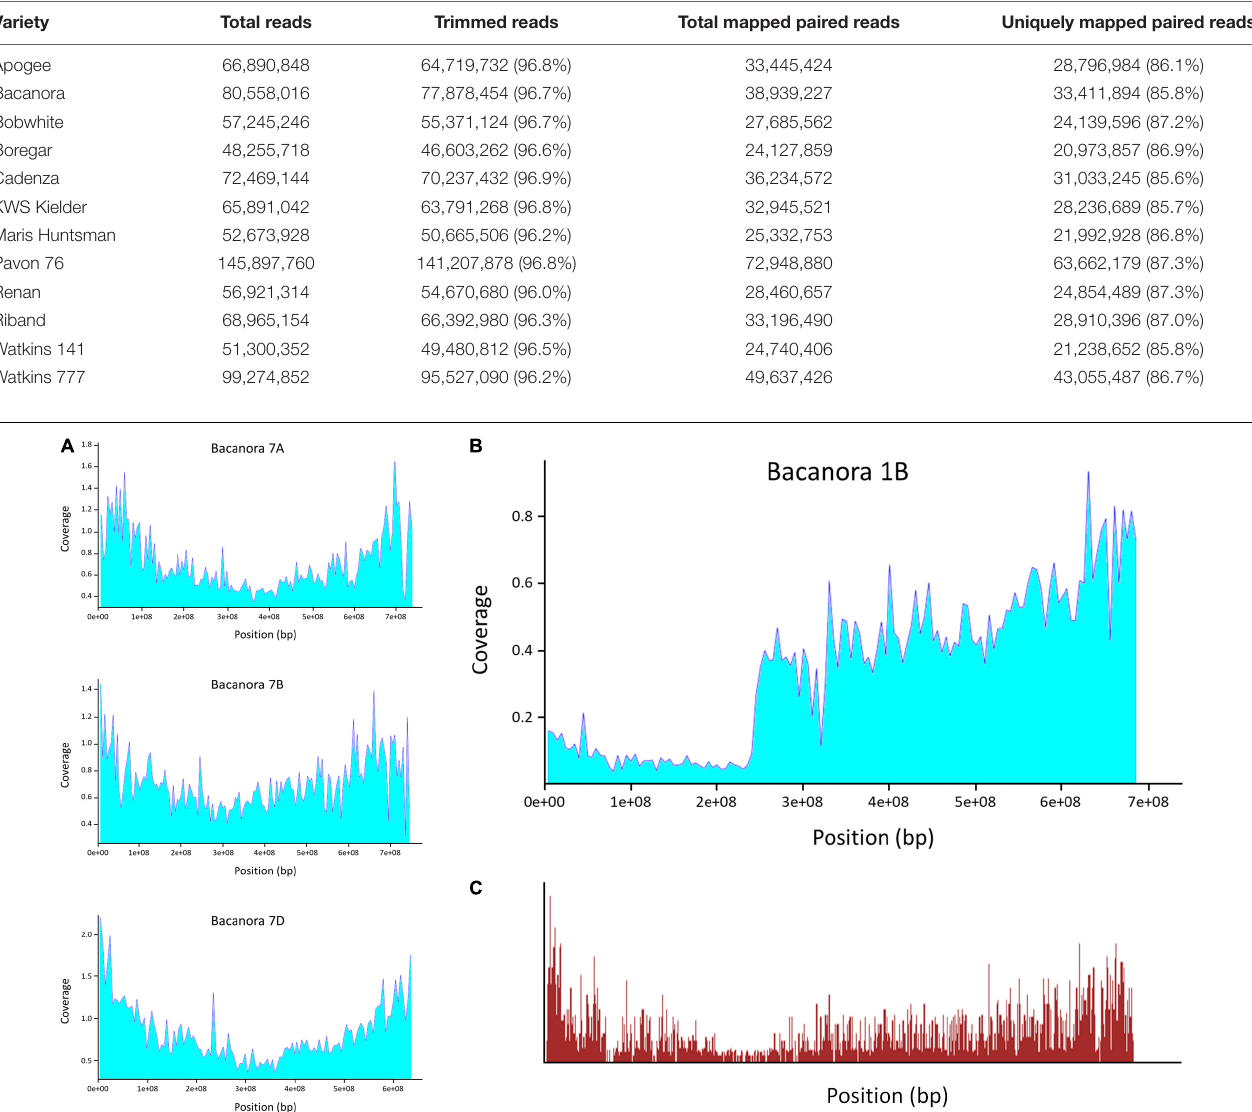
TABLE 1 | Read statistics before and after trimming with alignment statistics for total mapped and uniquely mapped reads.